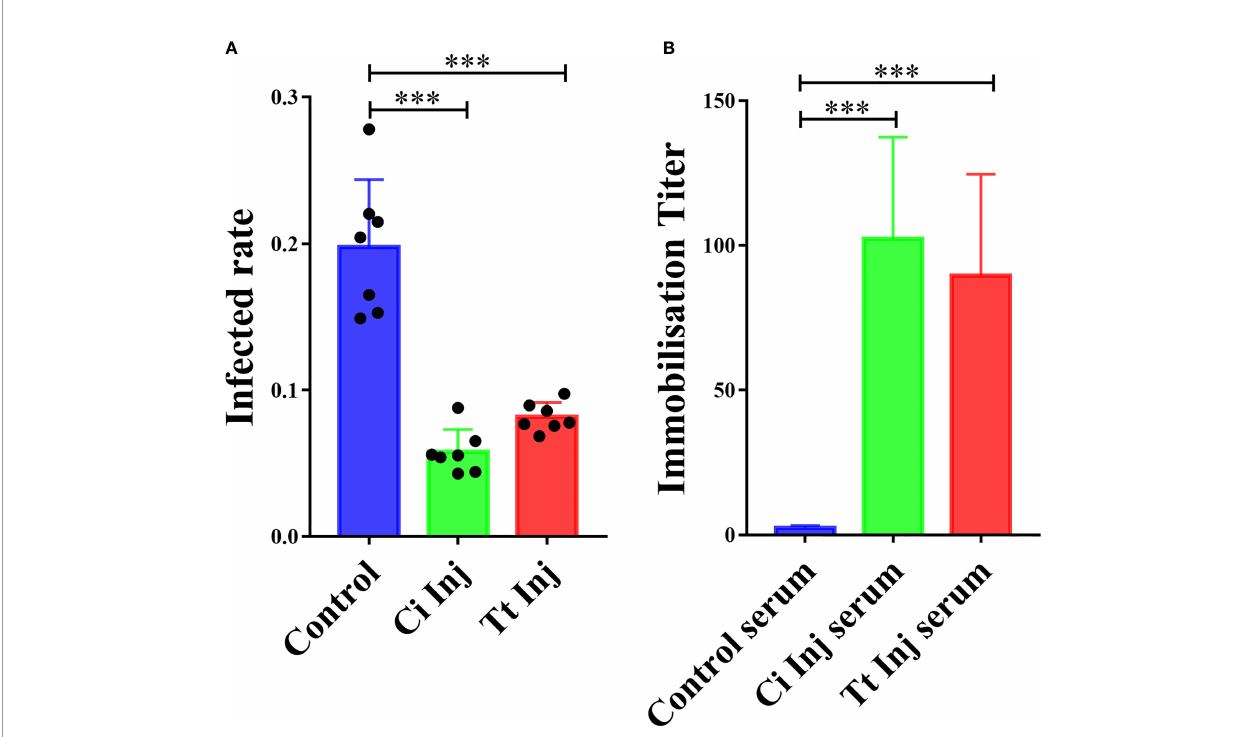
FIGURE 2 | Grouper immunized with C. irritans or T. thermophila are resistant to C. irritans infection. (A) C. irritans infection rate of C. irritans – or T. thermophila – immunized groupers (n = 7). Signi fi cant differences are represented as *** (p < 0.001). (B) Increased immobilization titers were found in serum from C. irritans – or T. thermophila – immunized groupers (n = 5). Signi fi cant differences are represented as *** (p <